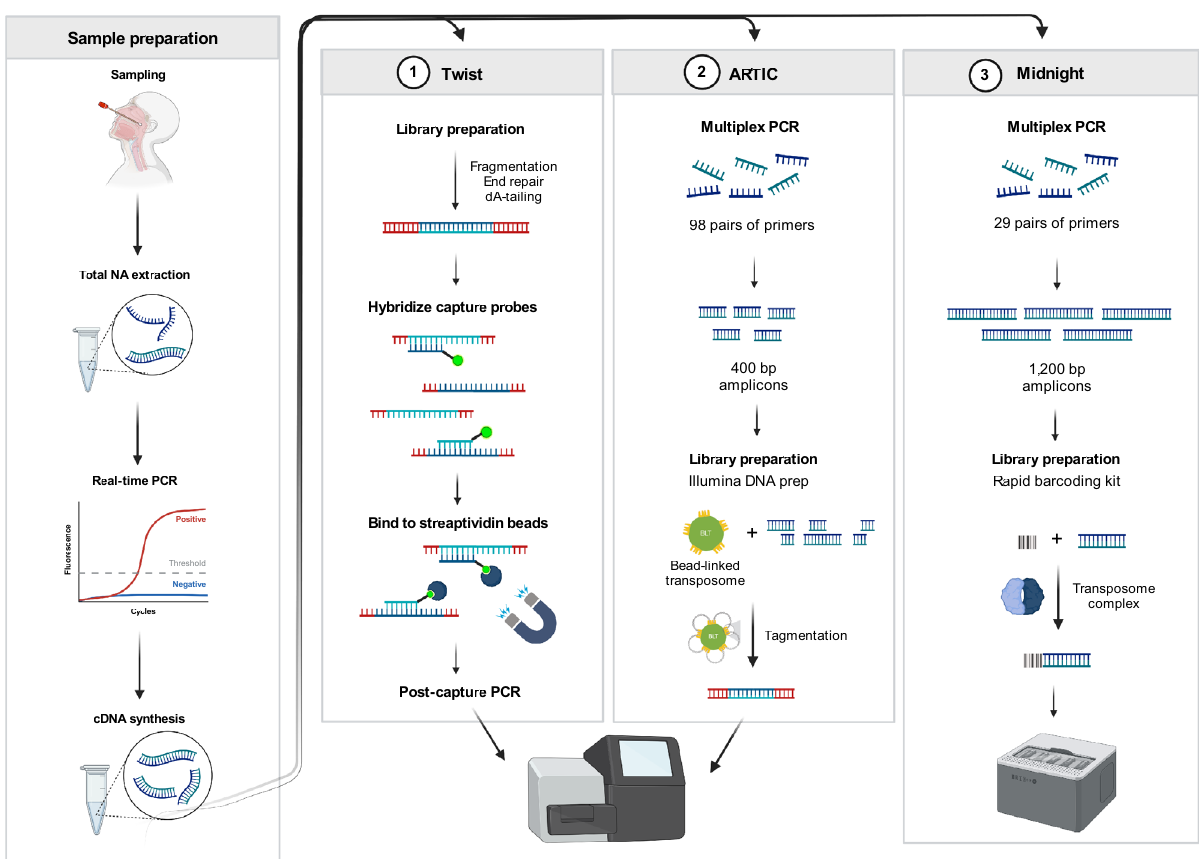
Figure 1. Schematic overview of the methods being compared. PCR‑positive SARS‑CoV‑2 samples were sequenced with three different workflows; 1. Twist bait hybridization enrichment method sequenced on the Illumina MiSeq. 2. ARTIC V3 tiled amplicon enrichment sequenced on the Illumina MiSeq. 3. Midnight tiled amplicon enrichment long reads sequenced on the Oxford Nanopore Technologies GridIon. Image created